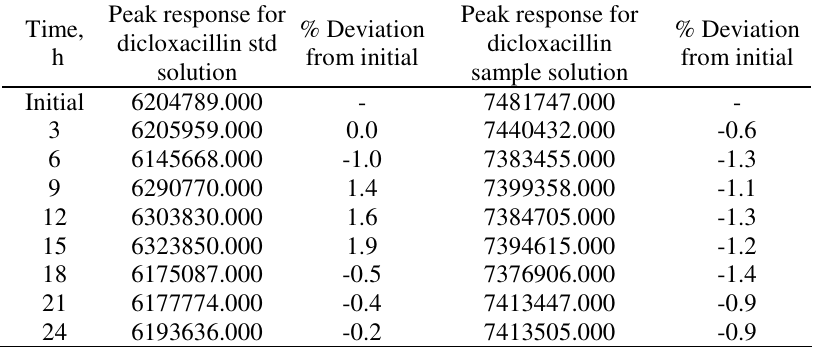
Table 7. Solution stability study analysis for dicloxacillin capsules dosage form.